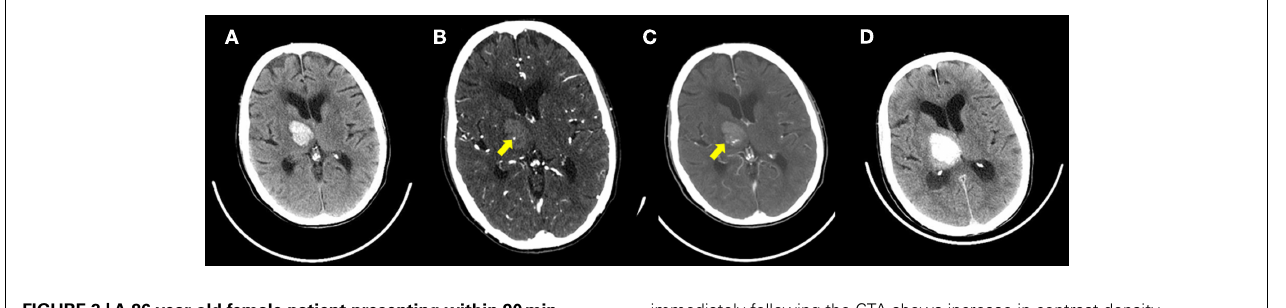
FIGURE 3 |A 86 year old female patient presenting within 90min of symptom onset. (A) Unenhanced CT demonstrates right thalamic and internal capsule hematoma with associated third ventricle mass effect. (B) A small focus of enhancement consistent with the Spot Sign is seen on the CTA raw image. (C) Post-contrast CT performed